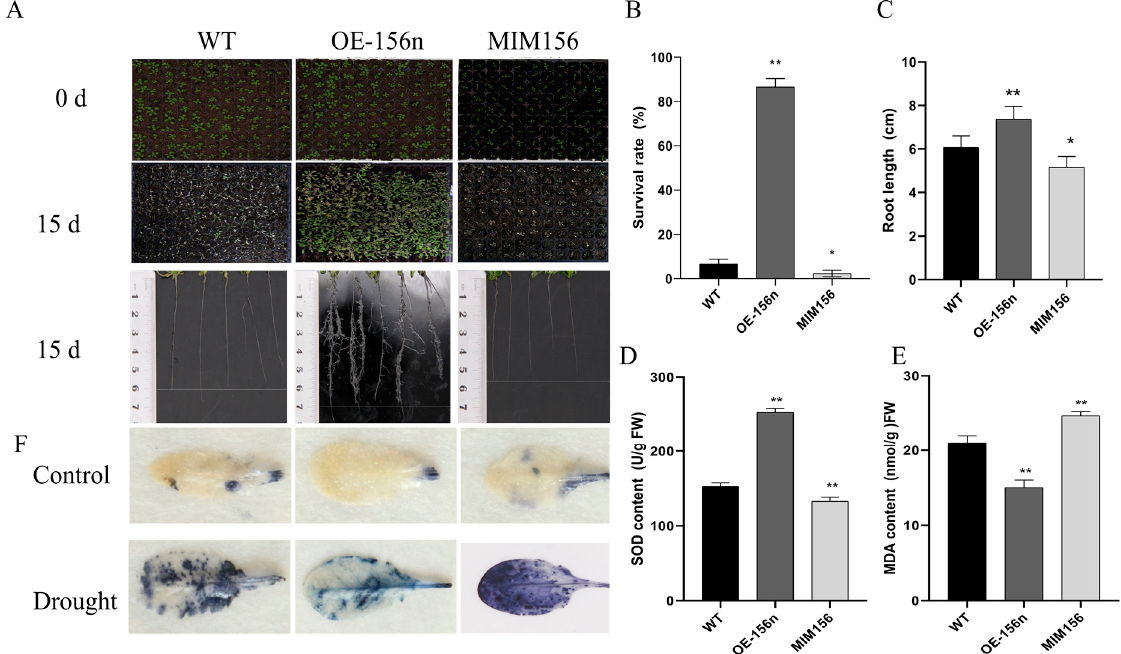
Figure 3. Overexpression of Mdmir156n enhanced the drought tolerance in transgenic A. thaliana : ( A ) Phenotypes of WT, OE-156n, and MIM156 lines after natural drought for 15 days. ( B ) Survival rates of WT, OE-156n, and MIM156 lines after re-watering for 3 d. ( C ) The root length of WT, OE-156n, and MIM156 lines after drought treatment for 15 days. ( D ) Measurement of SOD activities in WT, OE-156n, and MIM156 lines. ( E ) Measurement of MDA content in WT, OE-156n, and MIM156 lines. ( F ) Histochemical staining of NBT for O 2 − accumulation in WT, OE-156n, and MIM156 lines after drought treatment for 15 d. Values are means SD of three independent biological replicates. Asterisks indicate statistically signi fi cant di ff erences (* p < 0.05, ** p < 0.01, one-way ANOVA).